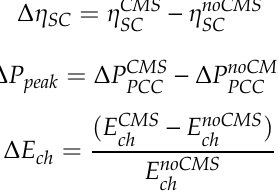
Figure 16. PCC power profiles calculated without EVs ( red ) and with EVs charging ( blue ) in SA ‐ CMS mode, according to the different values of the initial SOC. The PV generation changes according to the worst conditions ( left ), the mean conditions ( center ), and the best conditions ( right ), as well as the ∆ P values.